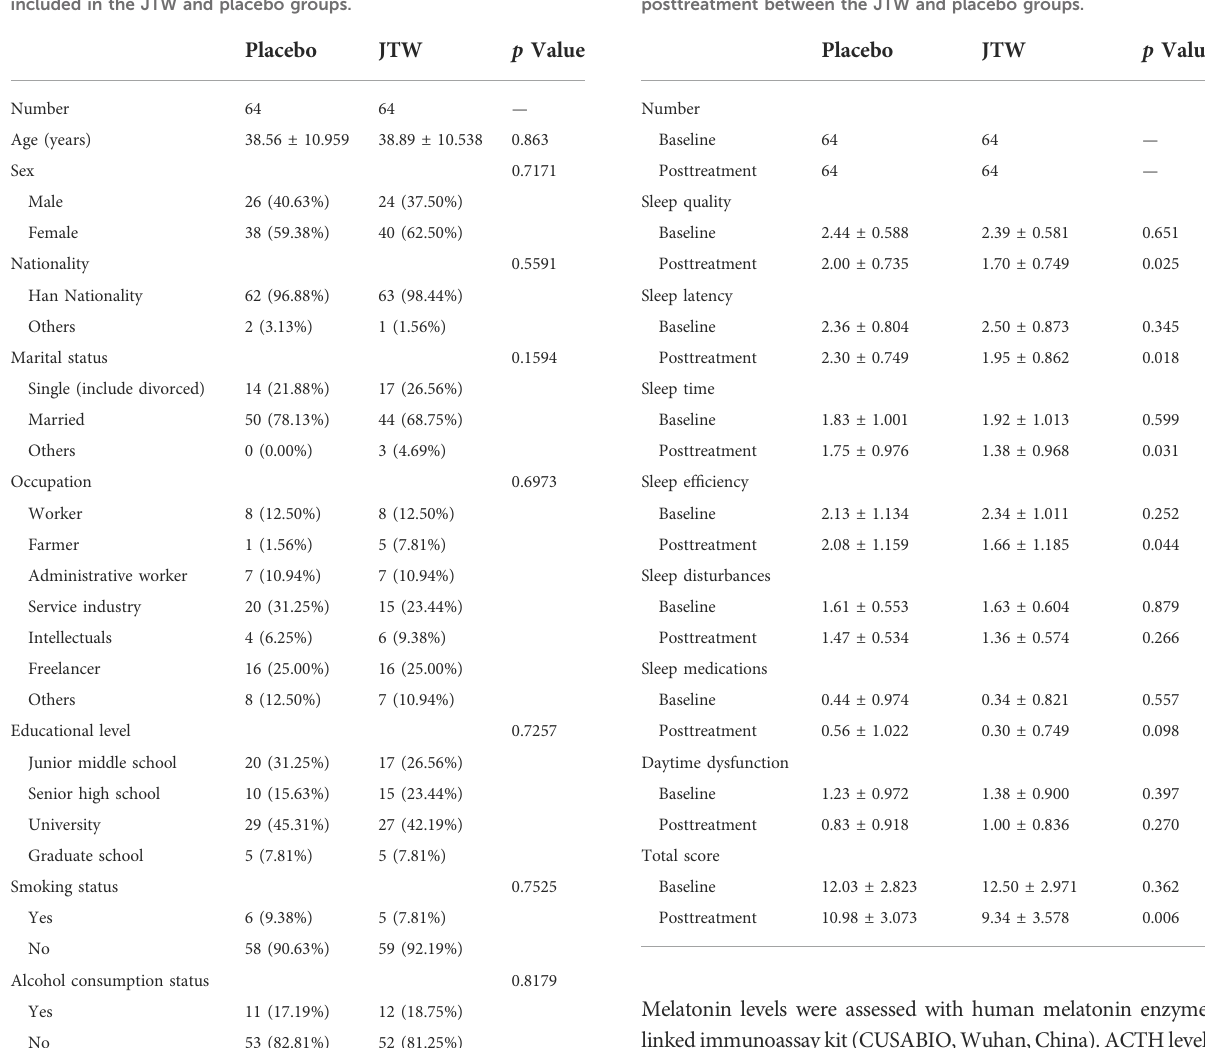
TABLE 1 Demographic and clinical characteristics of the participants included in the JTW and placebo groups.